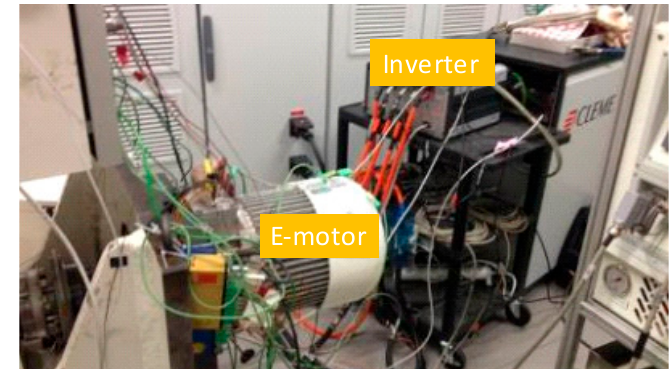
Figure 6. Full instrumentation of the prototype of 60 kW, 12 krpm on the high-speed test-bench.